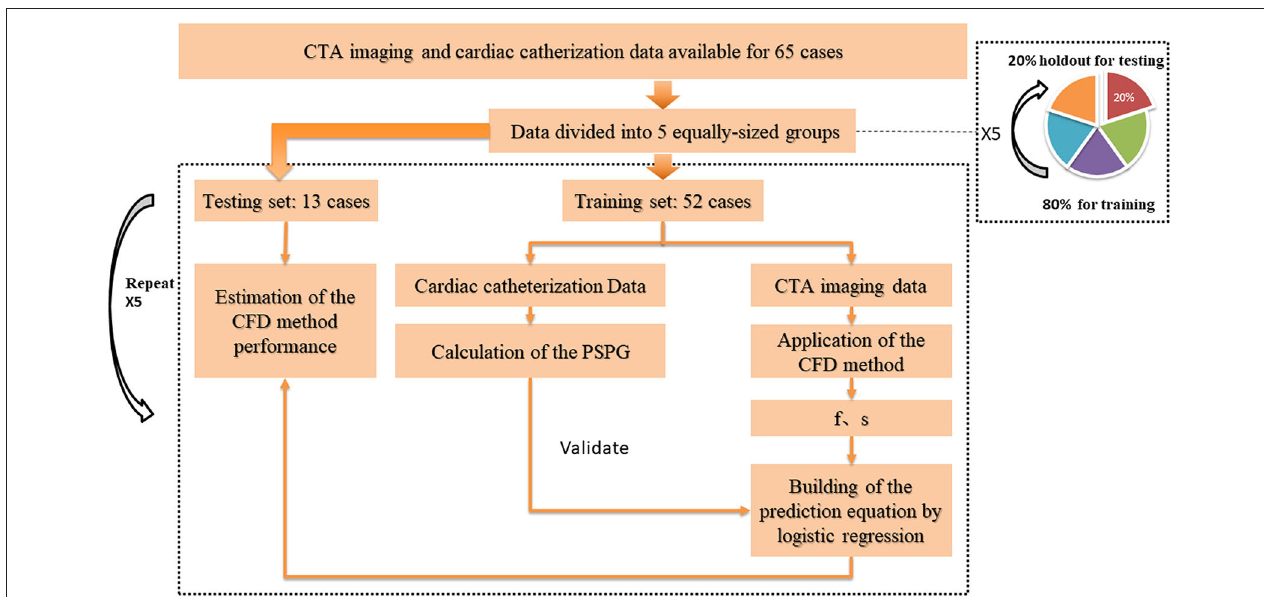
FIGURE 3 | Cross-validation pathway. Five equally-sized groups were stratified so to have approximately the same proportion of genders, ages, and patients with CoA. One of them (20% of the data) was holdout for testing, while the others (80% of the data) were used as the training set. To estimate the CFD performance, we applied a 5-fold cross-validation procedure on all groups: each time, the CFD simulation was performed on a different training set. The parameters f and s, obtained from the simulation results, were used to build a prediction equation by using logistic regression, before testing the prediction model on the unseen test set.